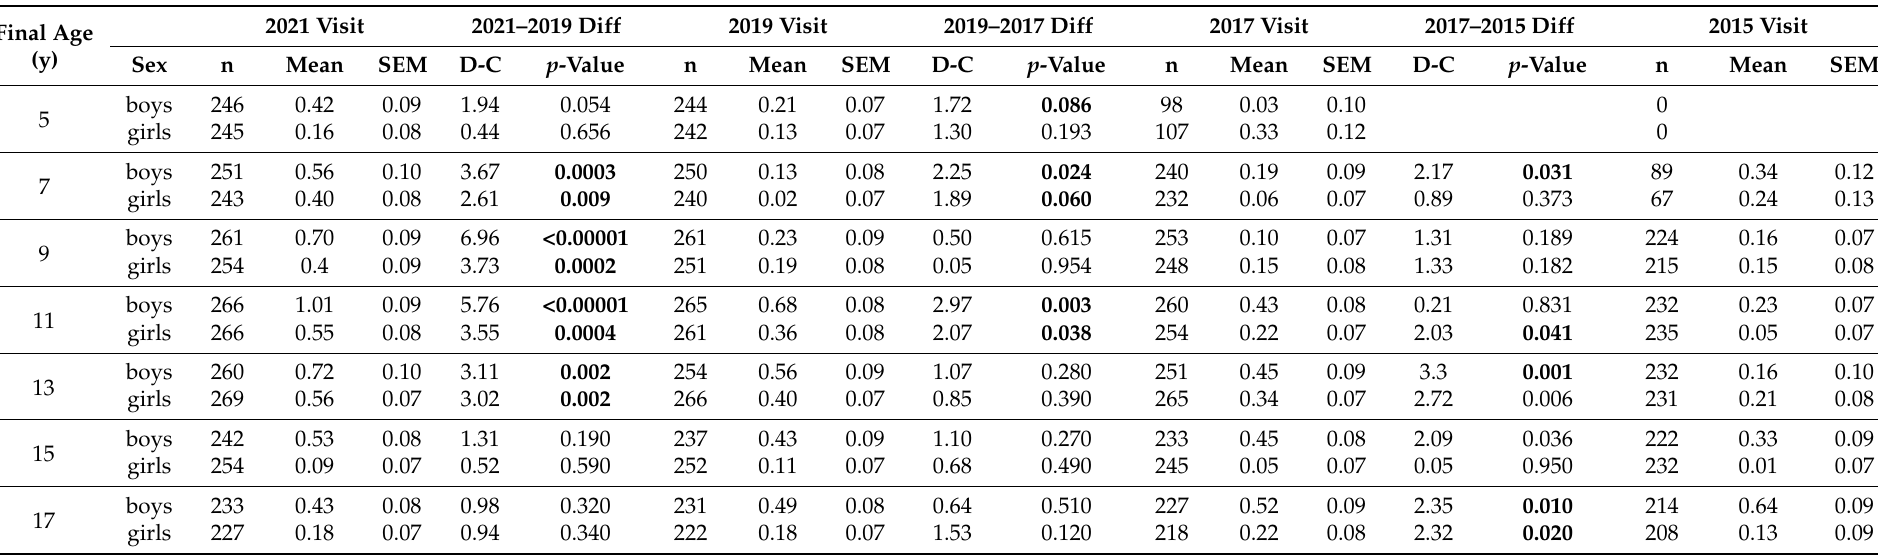
Table 1. Mean values, number of probands, and the standard error of the mean (SEM) for each age group and sex. Differences between re-tests were calculated using Durbin-Conover post hoc test